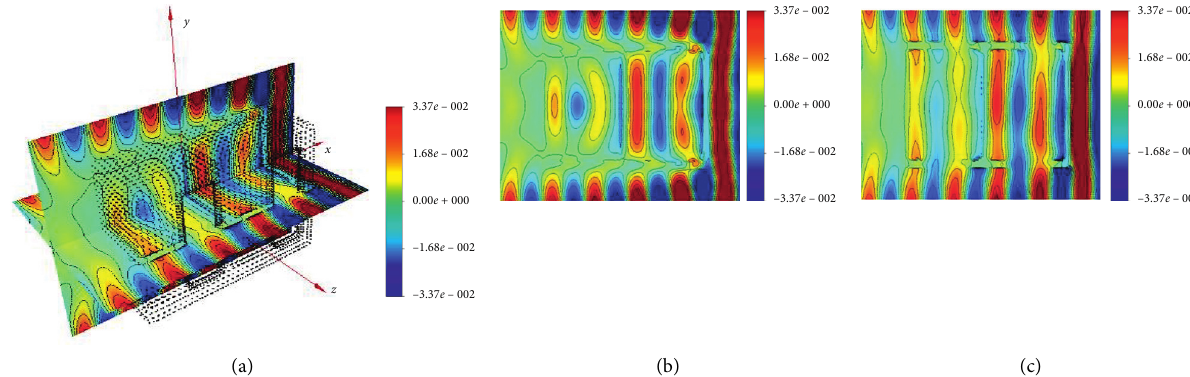
Figure 4: The isometric (a), x - y plane (b), and x - z plane (c) view of the rooms for 450MHz.